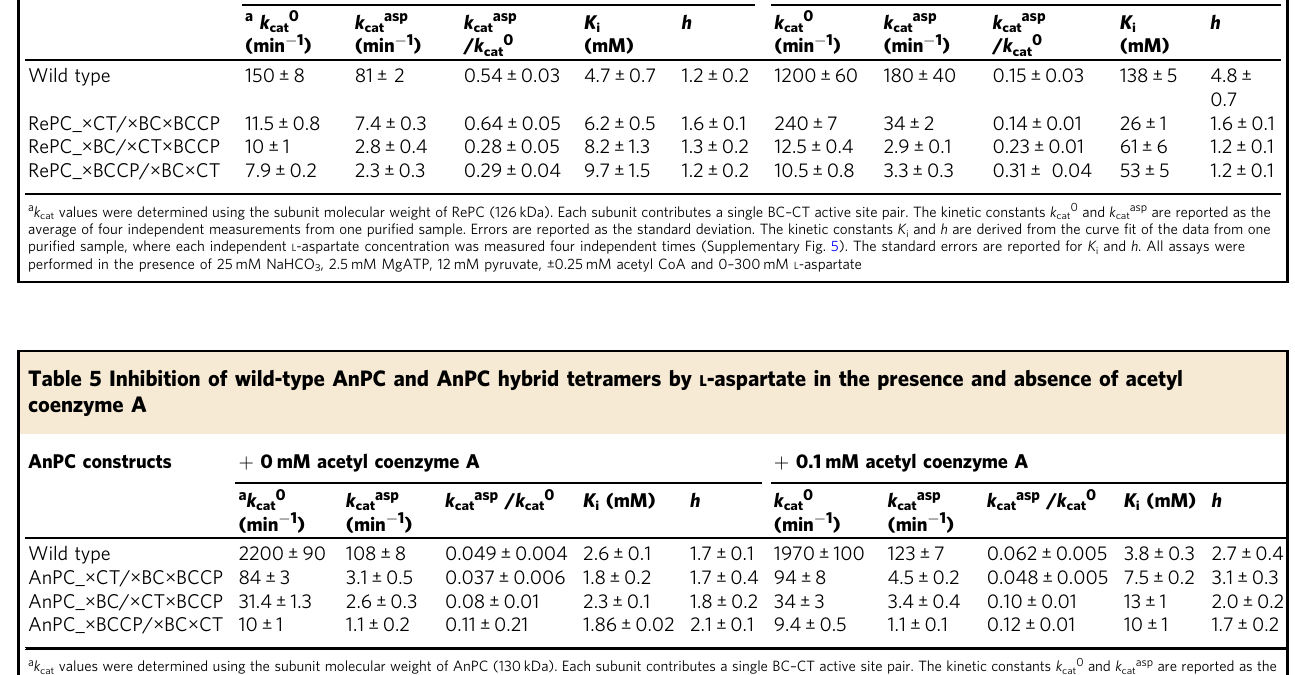
Table 4 Inhibition of wild-type RePC and RePC hybrid tetramers by L -aspartate in the presence and absence of acetyl coenzyme A